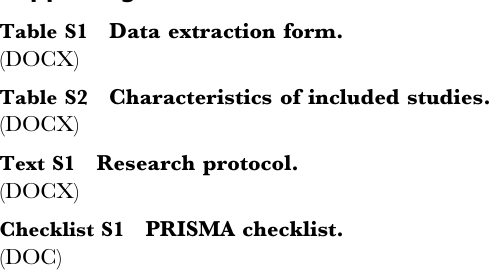
Table S1 Data extraction form. Table S2 Characteristics of included